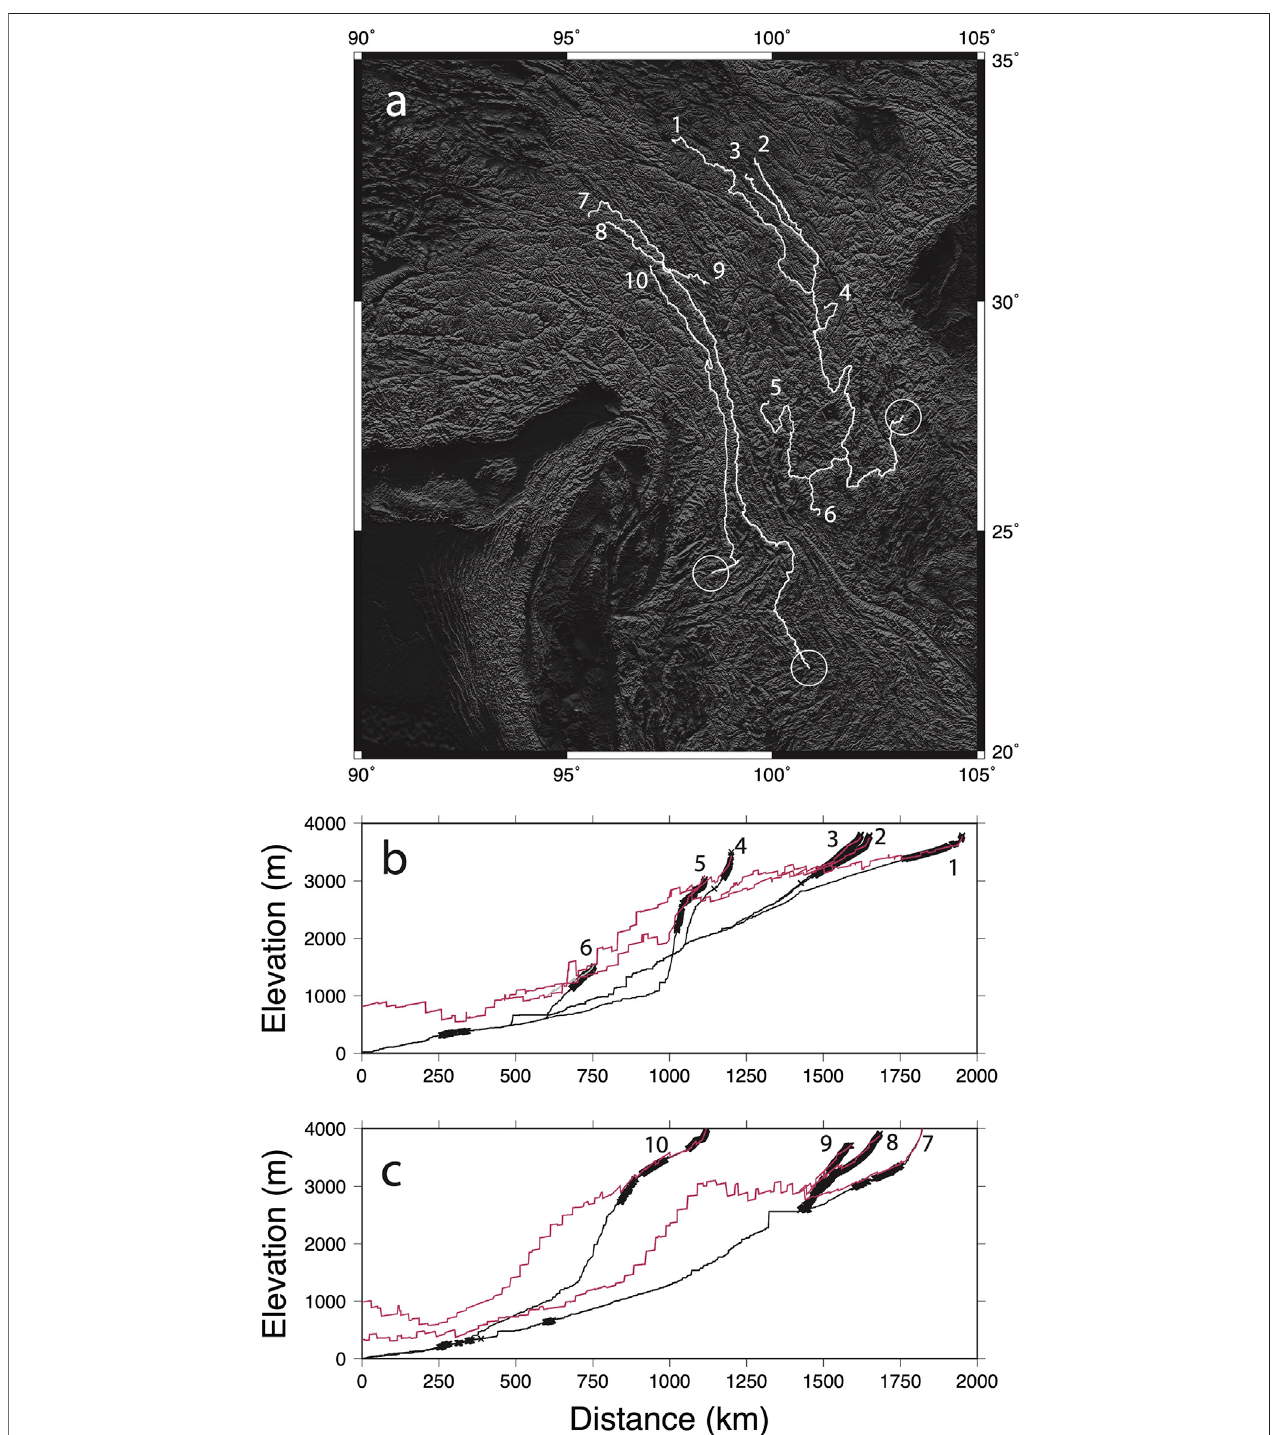
FIGURE 7 | Comparison with river pro fi les. (A) Location map showing the rivers plotted in (B) and (C) ; (B) River long-pro fi les extracted from the down sampled DEM, black lines. The crosses are the low-relief nodes used in the inversion, these appear as thick black lines where they are closely spaced. The pink lines are the predicted elevations and account for spatial variability in u* and S.U. and are therefore not monotonic. The stepped nature is due to the fi ne resolution of the pixels used for the inversion and the fact that the values of u* and S.U. vary over short wavelengths; (C) River long-pro fi les extracted from Mekong and a tributary of the Salween. Larger amounts of incision are predicted for these rivers.